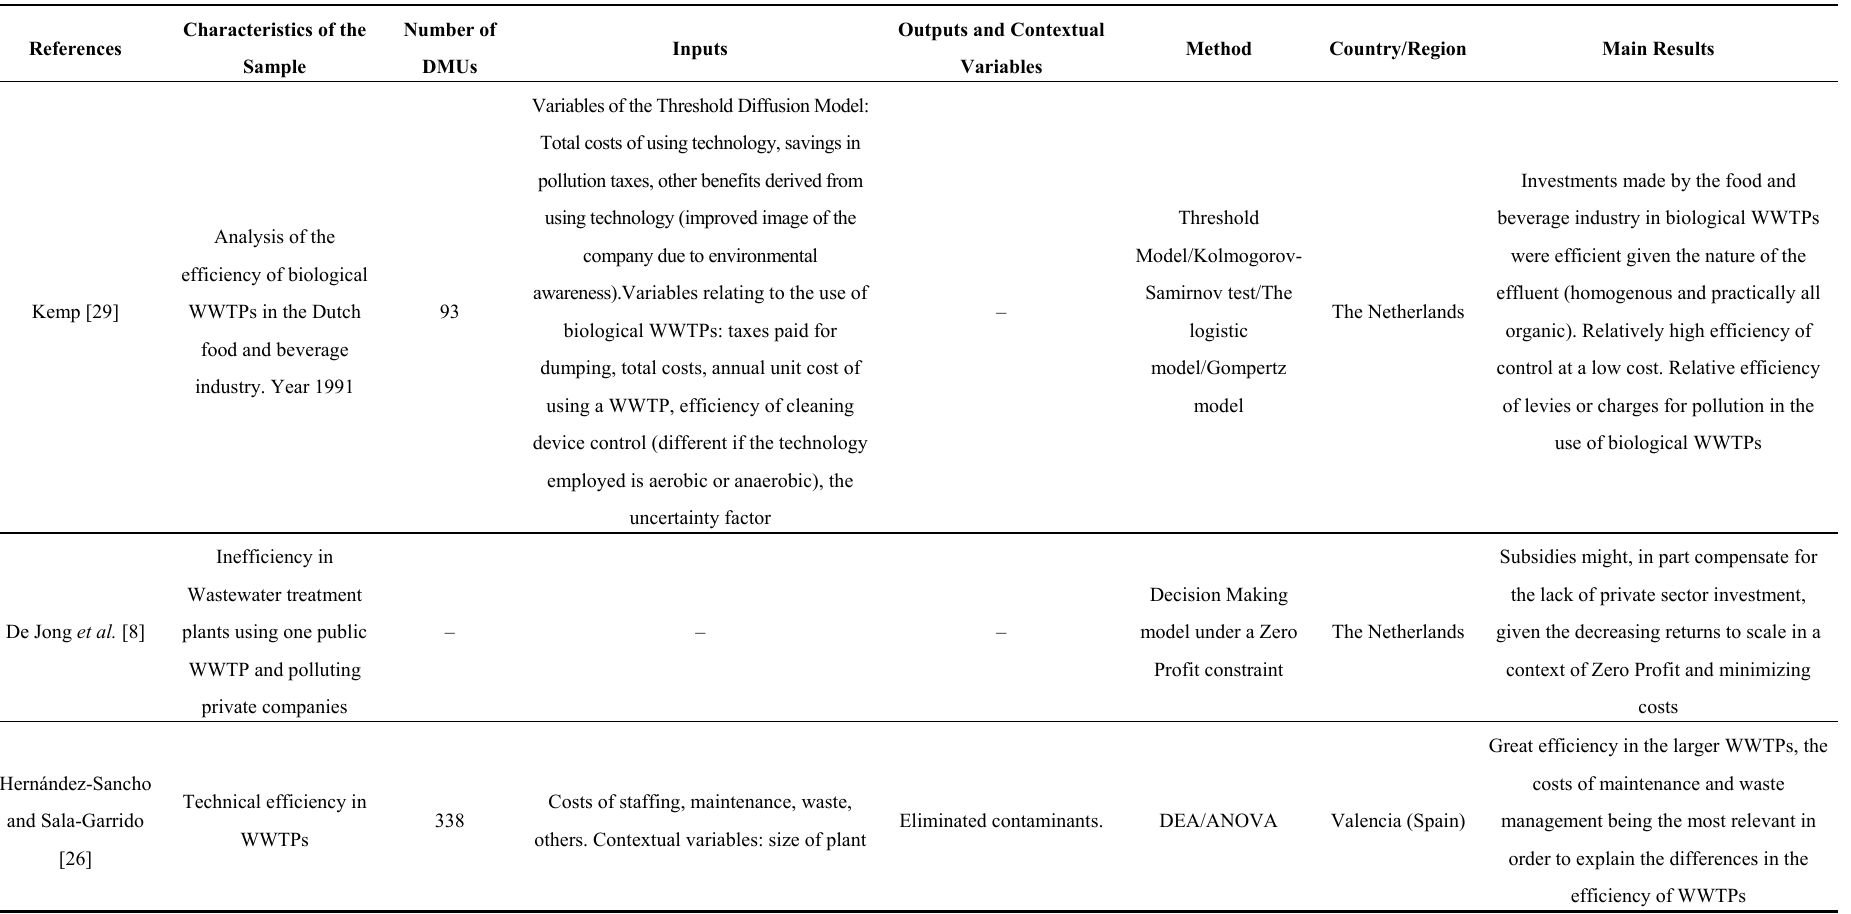
Table 1. Studies on productivity and efficiency in wastewater treatment